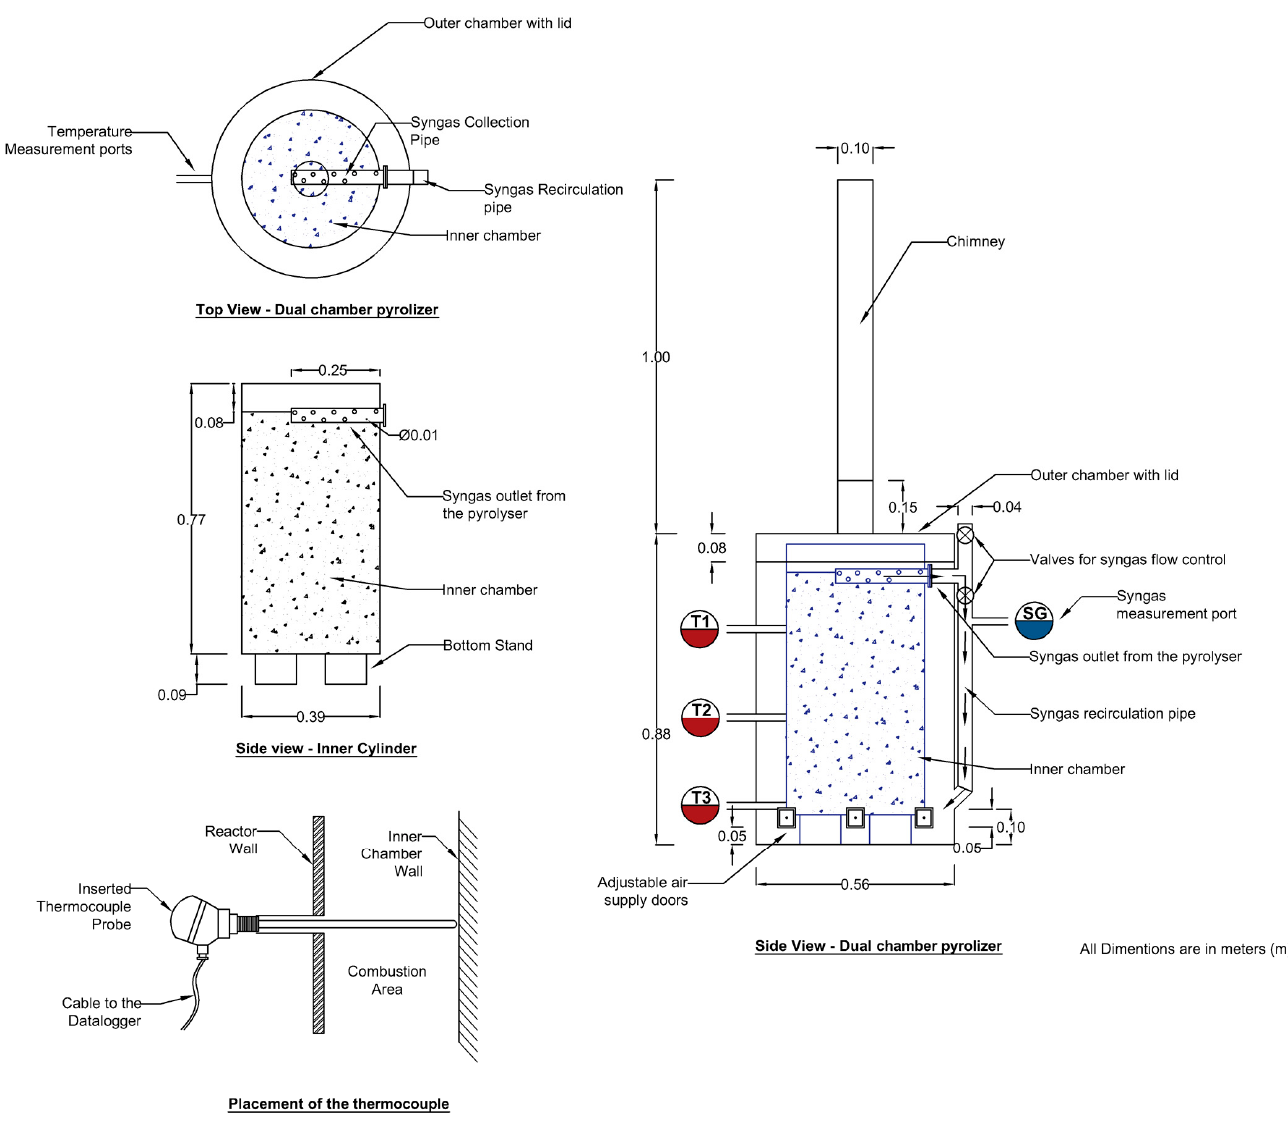
Figure 2. Schemes of the dual-chamber pyrolizer.